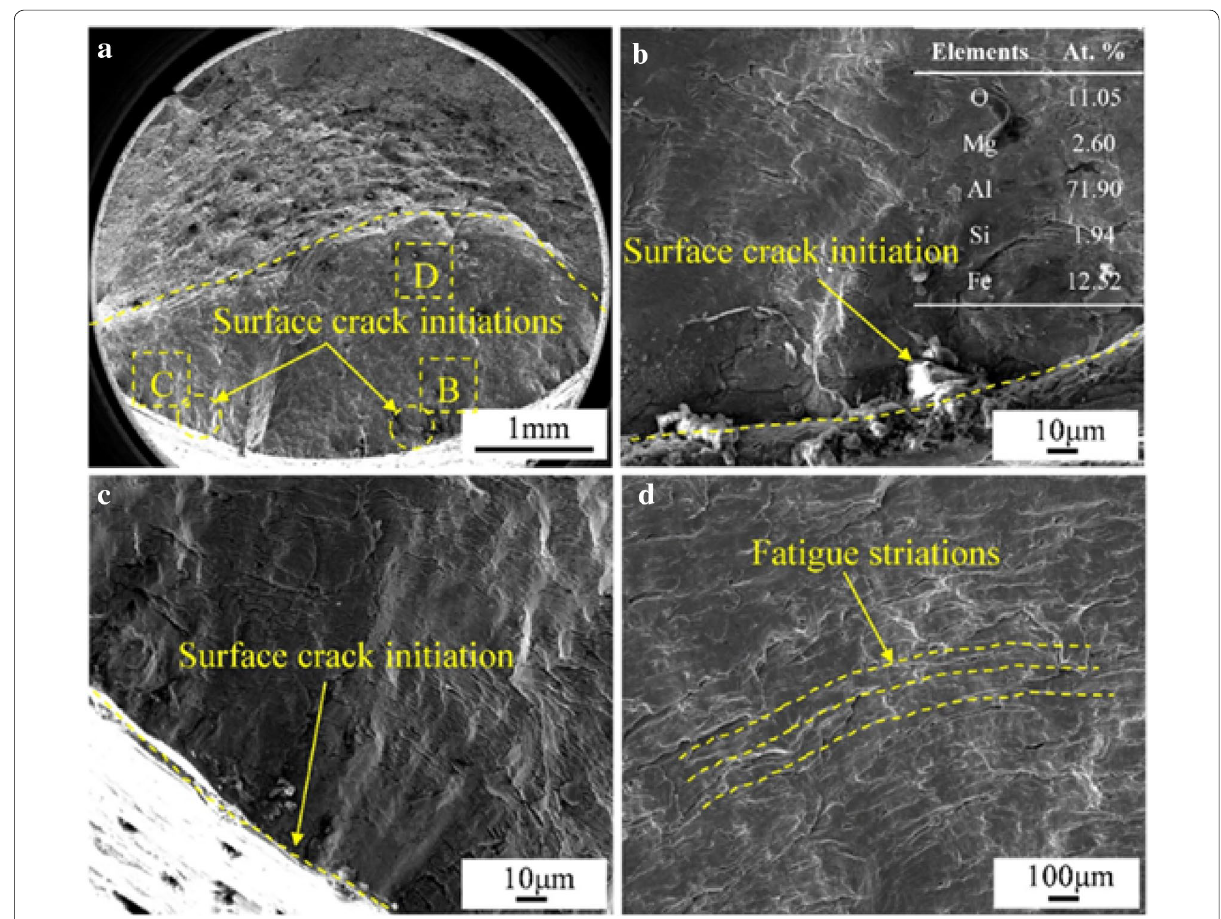
Figure 8 Fracture morphology of the specimen failed at OTZ at 300 °C: a the overall micrograph of the fracture surface, b magnified micrograph of one surface crack initiation, c magnified micrograph of another surface crack initiation, d fatigue striations in the crack propagation